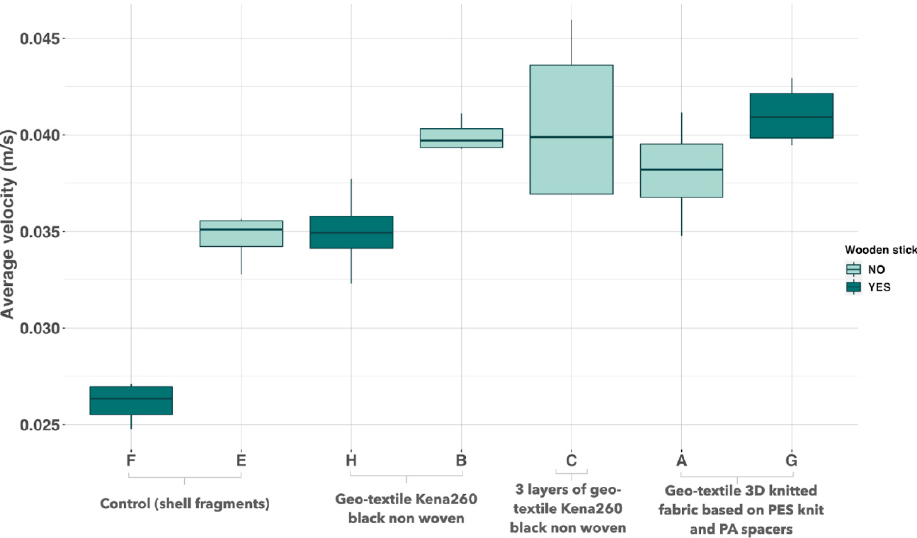
Figure 9. Box plot of the average velocity (m/s) above the gutter containing different substrate types. Four replicates were performed for each treatment, for which the average velocity is based on velocity measurement at five points along a horizontal transect above the gutter (Figure 5b). Colour represents the presence/absence of wooden sticks on the substrate.